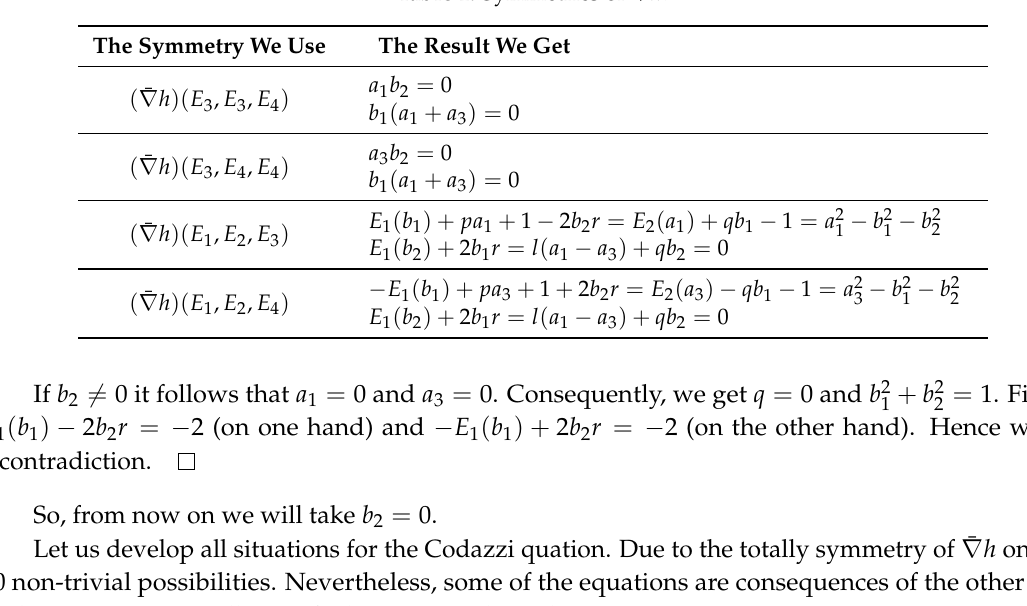
Table 1. Symmetries of ¯ ∇ h